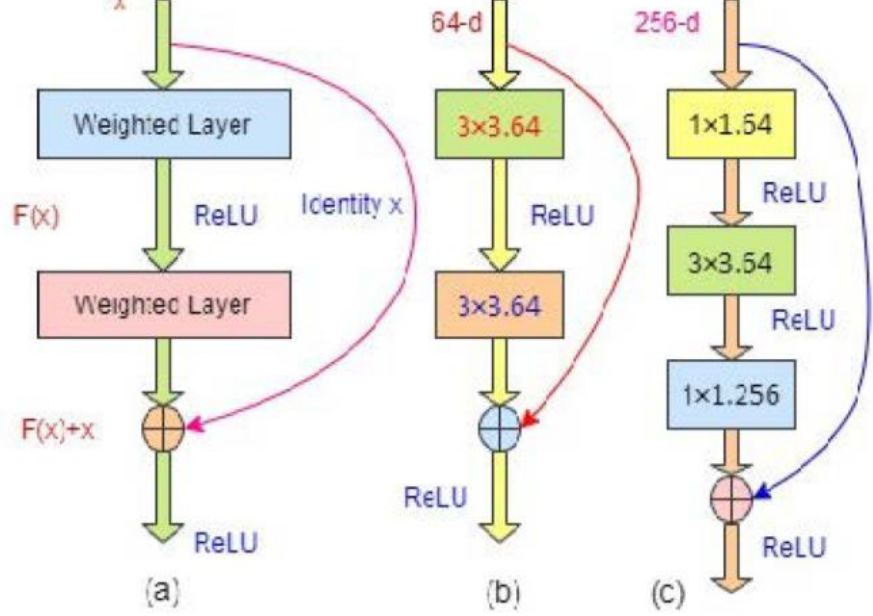
Figure 2. ( a ) The basic building block structure of residual network; ( b ) A building block for ResNet- 18/34; ( c ) A building block for ResNet-50/101/152 (bottleneck